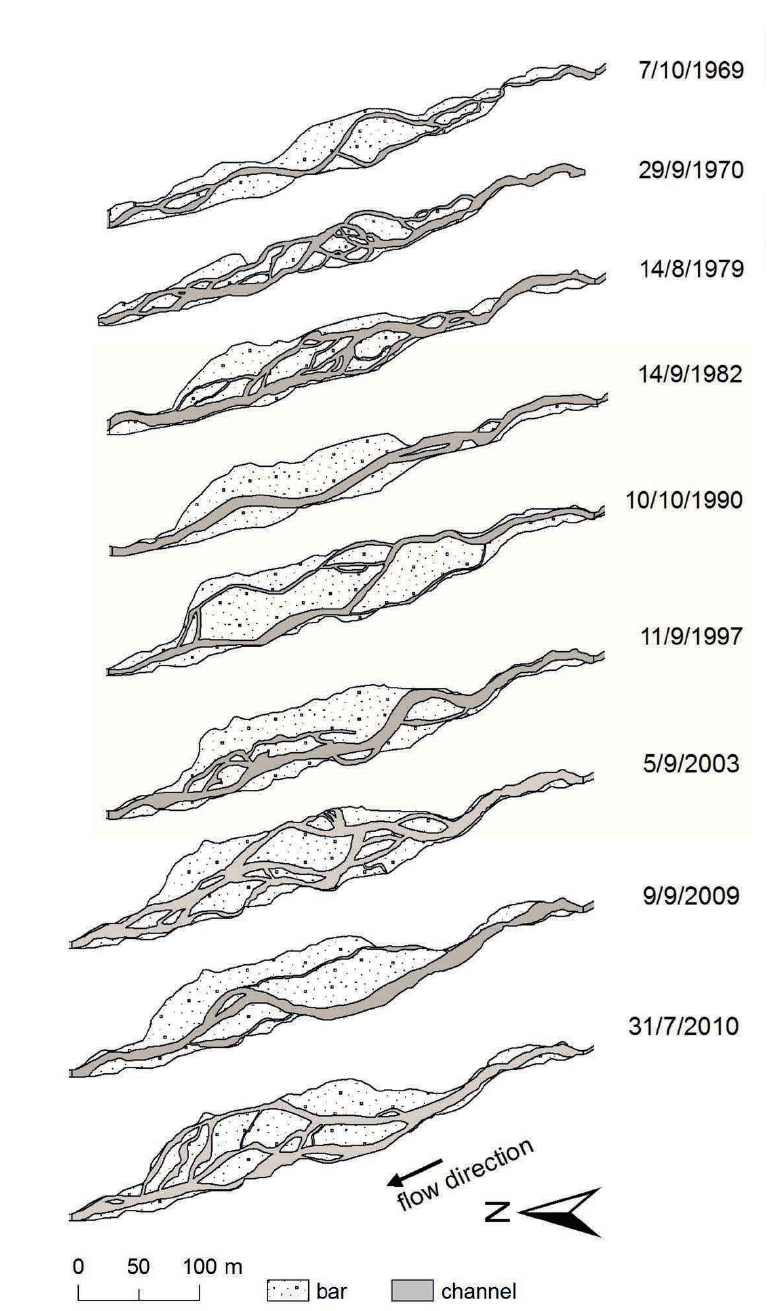
Fig. 4 Channel planform changes on the braid plain from 1969 to